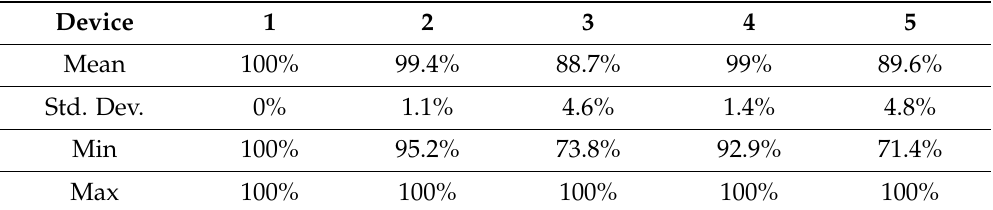
Table 3. Classification performance of five electronic targets in